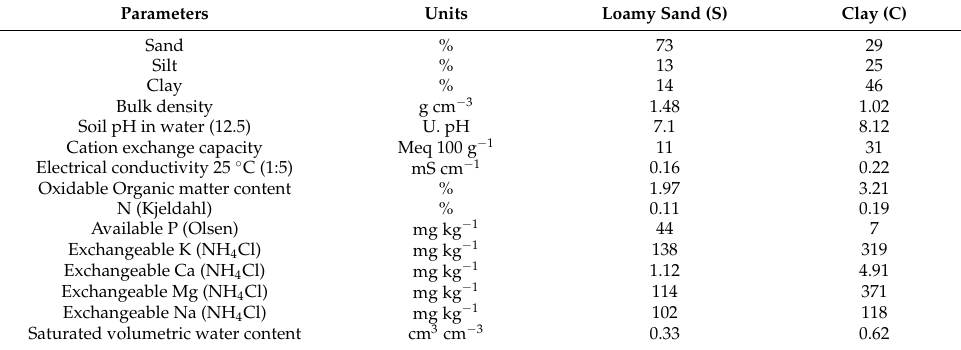
Table 1. Soil analysis of the two soil types used in the